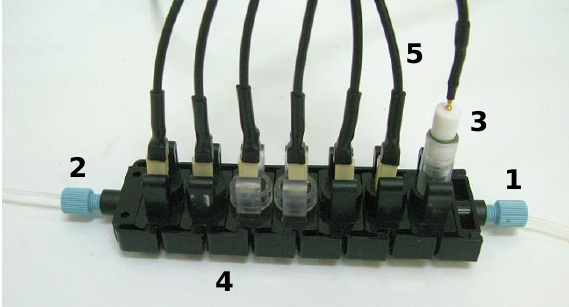
Figure 5. Example of an electronic tongue system with individual sensing modules applied for the analysis of fermentation: 1. inlet, 2. outlet, 3. reference electrode, 4. single modules with individual sensors, 6. electrical connections (reprinted with permission from [109] © Elsevier).